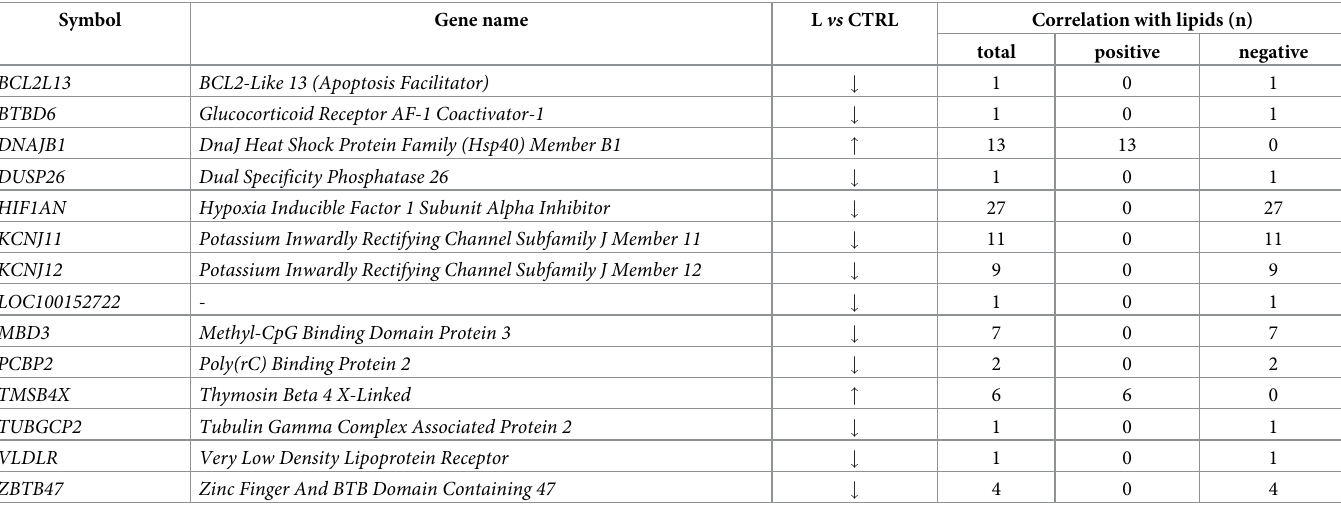
Table 3. List of genes showing correlation with lipids, in the two comparisons. Symbol Gene name L vs